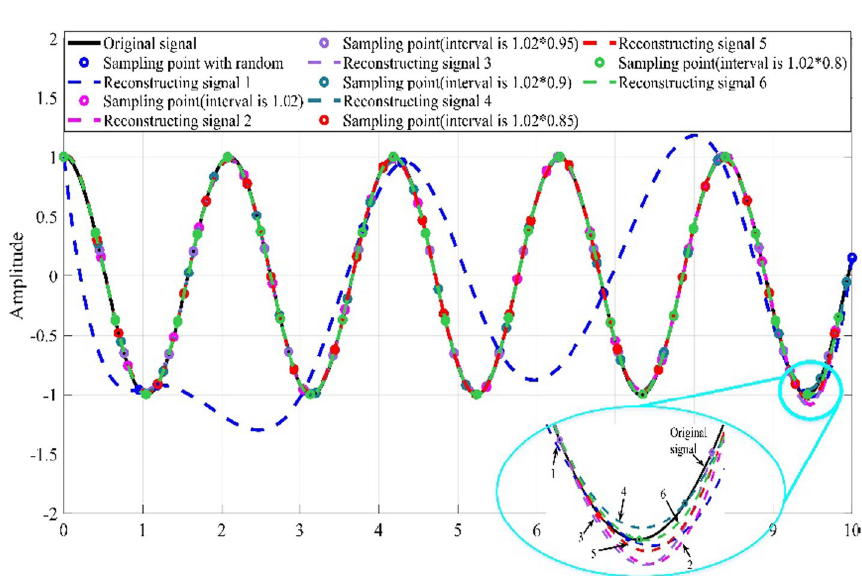
Fig. 7 Cosine signal, random sampling points, sampling points with equal arc length (interval is 1.02, 1.02 0.95, 1.02 0.90, 1.02 0.85, 1.02 0.80) and reconstructing signals, × × ×